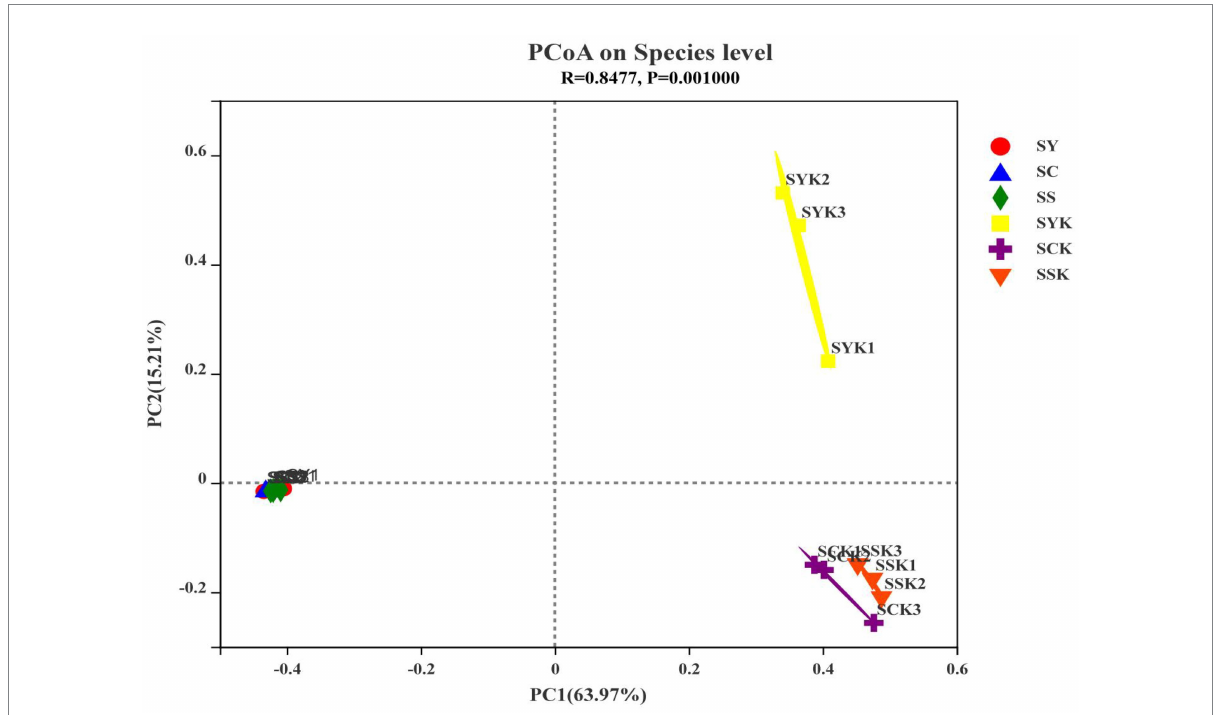
FIGURE 2 The principal coordinate analysis (PCoA) plot showing variation in bacterial community structure of growth stages. Each point represents an individual. SY, Fresh materials at booting stage; SC, Fresh materials at initial flowering; SS, Fresh materials at full flowering; SYK, Silage samples at booting stage; SCK, Silage samples at initial flowering; SSK, Silage samples at full